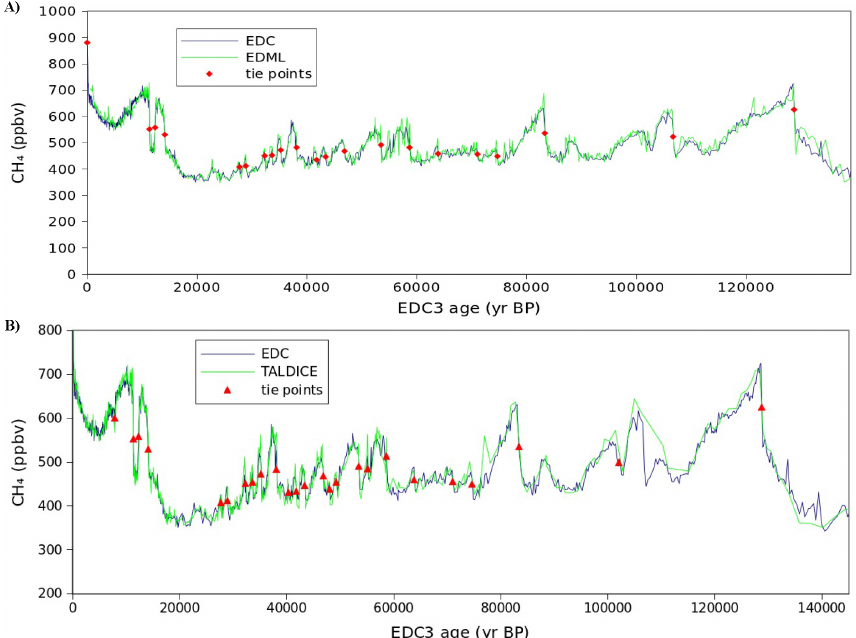
Fig. 6. Gas synchronisation between EDC and EDML (A) and between EDC and TALDICE (B) using the CH 4 records (Loulergue et al., 2007, 2008; Schilt et al., 2010; Buiron et al.,